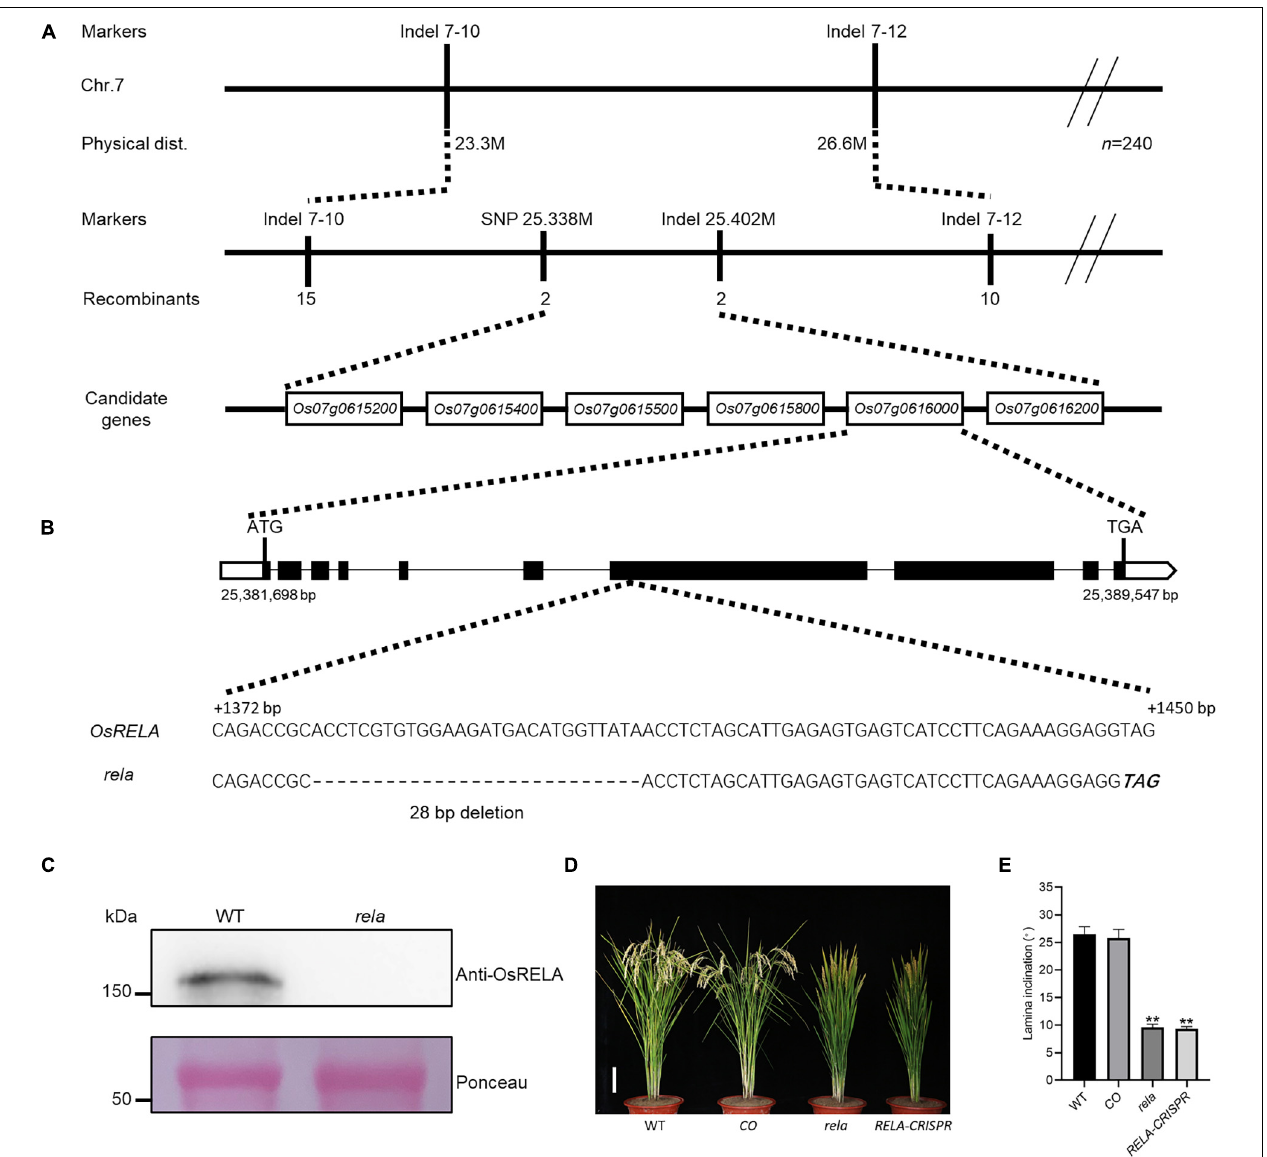
FIGURE 2 | Map-based cloning of OsRELA and complementation test. (A) Linkage map of the OsRELA locus. OsRELA is located on the long arm of chromosome 7, between the molecular marker SNP 25.338 M and Indel 25.402 M, a genomic region of ∼ 64 kb containing six ORFs. The markers, numbers of recombinants and candidate genes are indicated. (B) Schematic diagram of the OsRELA locus. Comparison with the wild-type sequence revealed a 28-bp deletion (dashed) in the seventh exon, generating a premature stop codon (bold italics). (C) Protein levels of OsRELA in the seedlings of wild-type and rela detected by immunoblot using anti-OsRELA–specific polyclonal antibodies. Ponceau staining of the Rubisco large subunit is shown as a loading control. Molecular masses of proteins (kDa) are shown on the left. (D) Plant morphology of wild-type, rela/proOsRELA:OsRELA ( CO ) , rela and RELA-CRISPR at the heading stage. Bar = 10 cm. (E) Quantification of the leaf inclination of the second lamina joint of wild-type, rela/proOsRELA:OsRELA ( CO ) , rela and RELA-CRISPR plants . Error bars are SD ( n = 20). Asterisks indicate significant differences from the WT (** P < 0.01, Student’s t